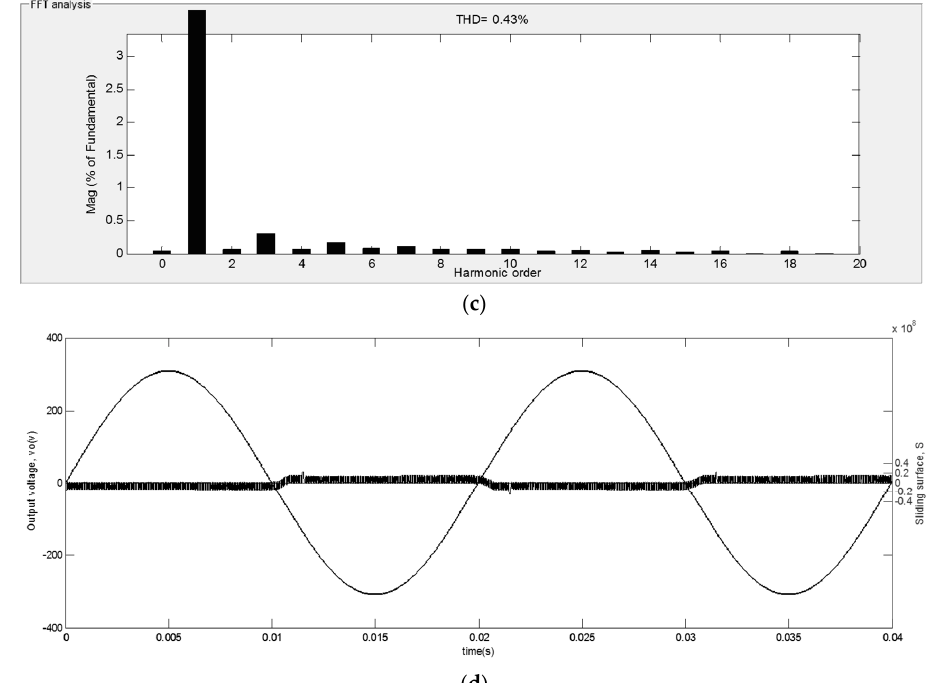
Figure 10. Simulation results for a bridge-rectifier load: ( a ) output voltage and load current for a bridge-rectifier load for the inverter controlled by MSSMC; ( b ) the spectrum of the load current for a bridge-rectifier load for the inverter controlled by MSSMC; ( c ) the spectrum of the output voltage for a bridge-rectifier load for the inverter controlled by MSSMC; and ( d ) simulated results of output voltage and sliding function for a diode rectifier load.